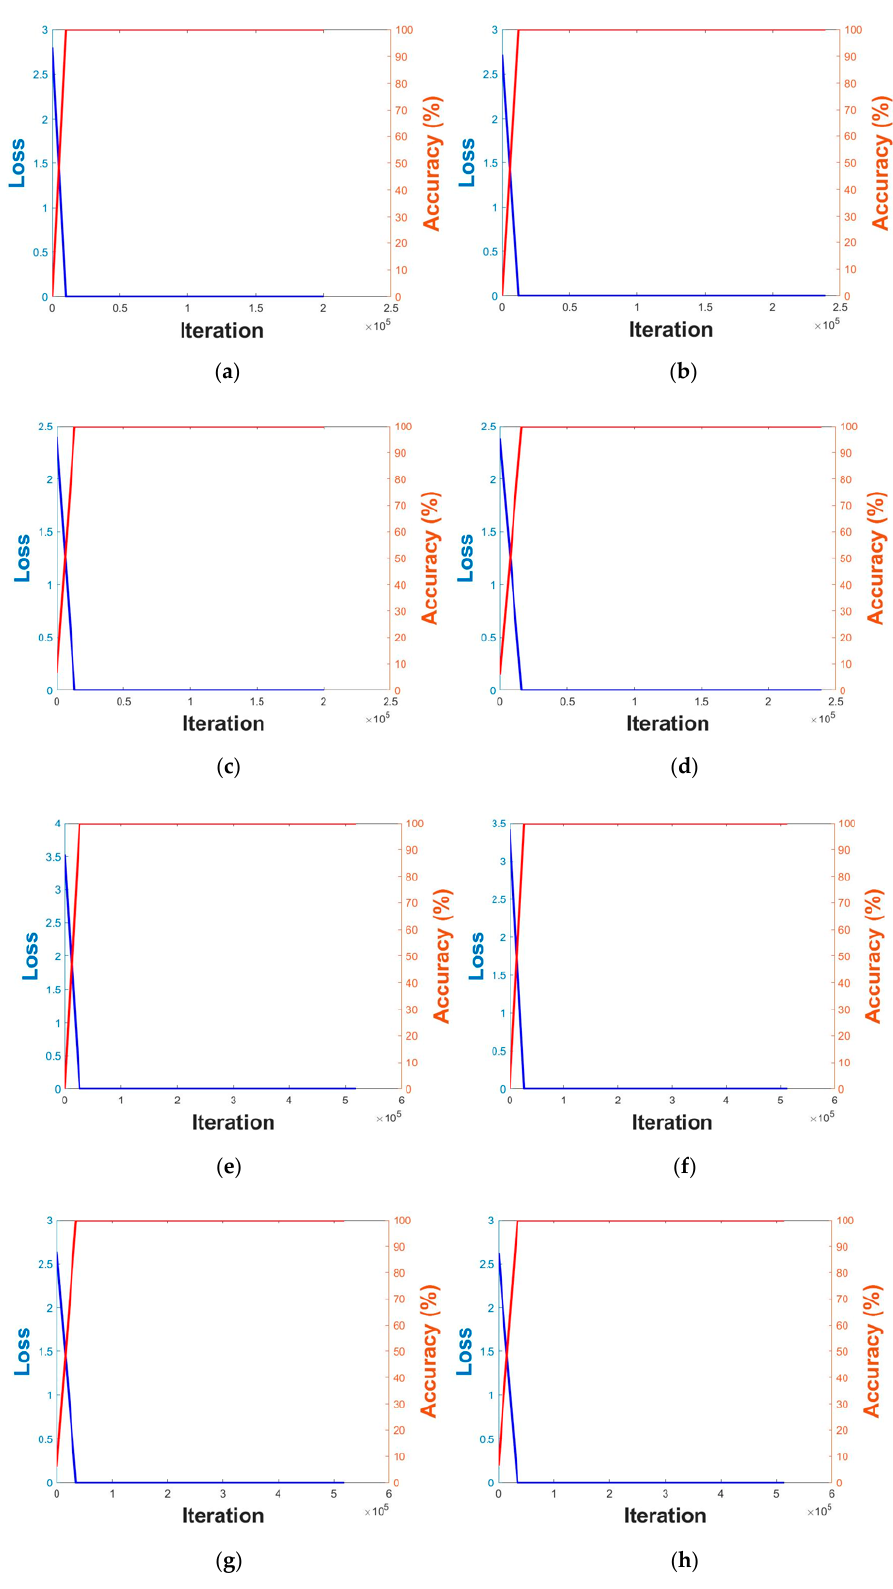
Figure 6. Plots depicting training loss and accuracy of DFB-DB2 (( a )–( d )) and ChokePoint dataset (( e )–( h )). Visual geometry group (VGG) face net-16 was used in the case of ( a , e ), the 1st fold was used for ( b , f ), the 2nd fold ResNet-50 was used in the case of ( c ), 1st fold in the case of ( g ), and the 2nd fold in the case of ( d , h